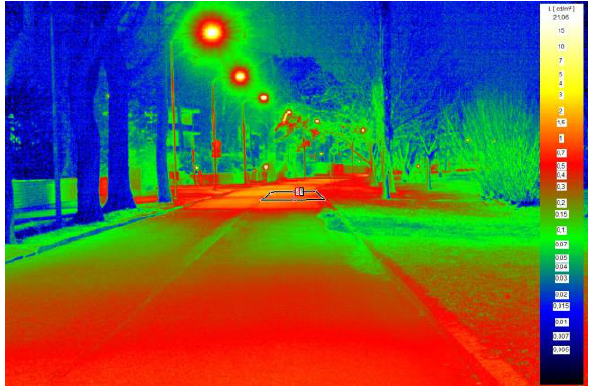
Figure 8. Luminance image in LMK LabSoft with areas of measurement marked at the center.